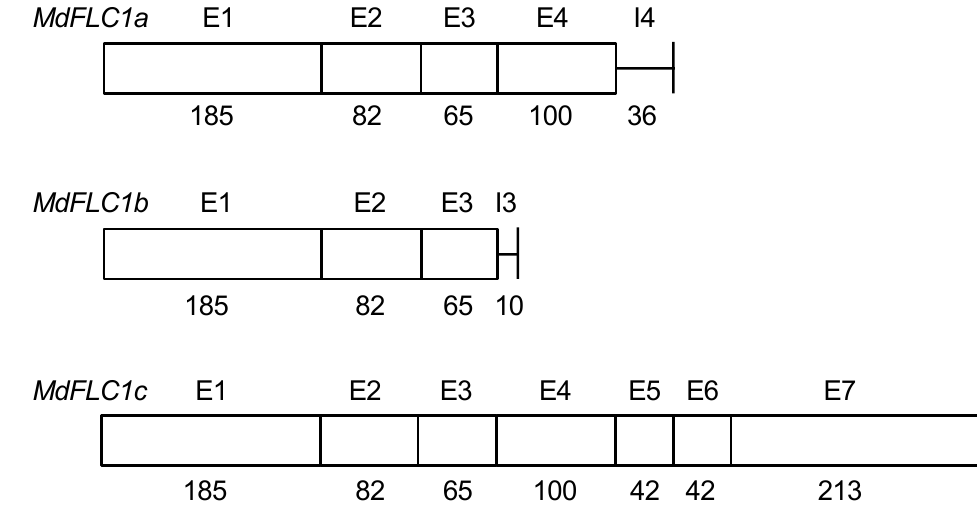
Figure 6. Transcript structures of MdFLC1 splice variants, MdFLC1a , MdFLC1b , and MdFLC1c . E and I with numbers indicate exons and introns, respectively. Numbers under the bar correspond to their sizes, in base